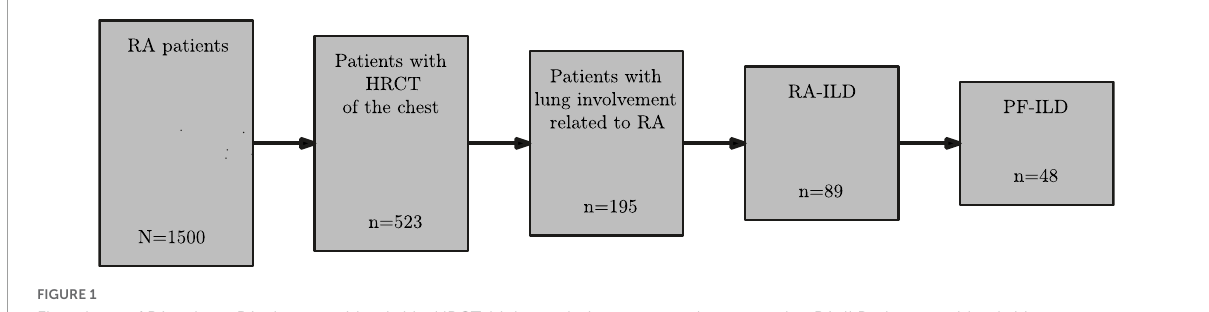
FIGURE1 Flowchart of RA cohort. RA, rheumatoid arthritis; HRCT, high-resolution computed tomography; RA-ILD, rheumatoid arthritis associated-interstitial lung disease; PF-ILD, progressive fibrosing interstitial lung